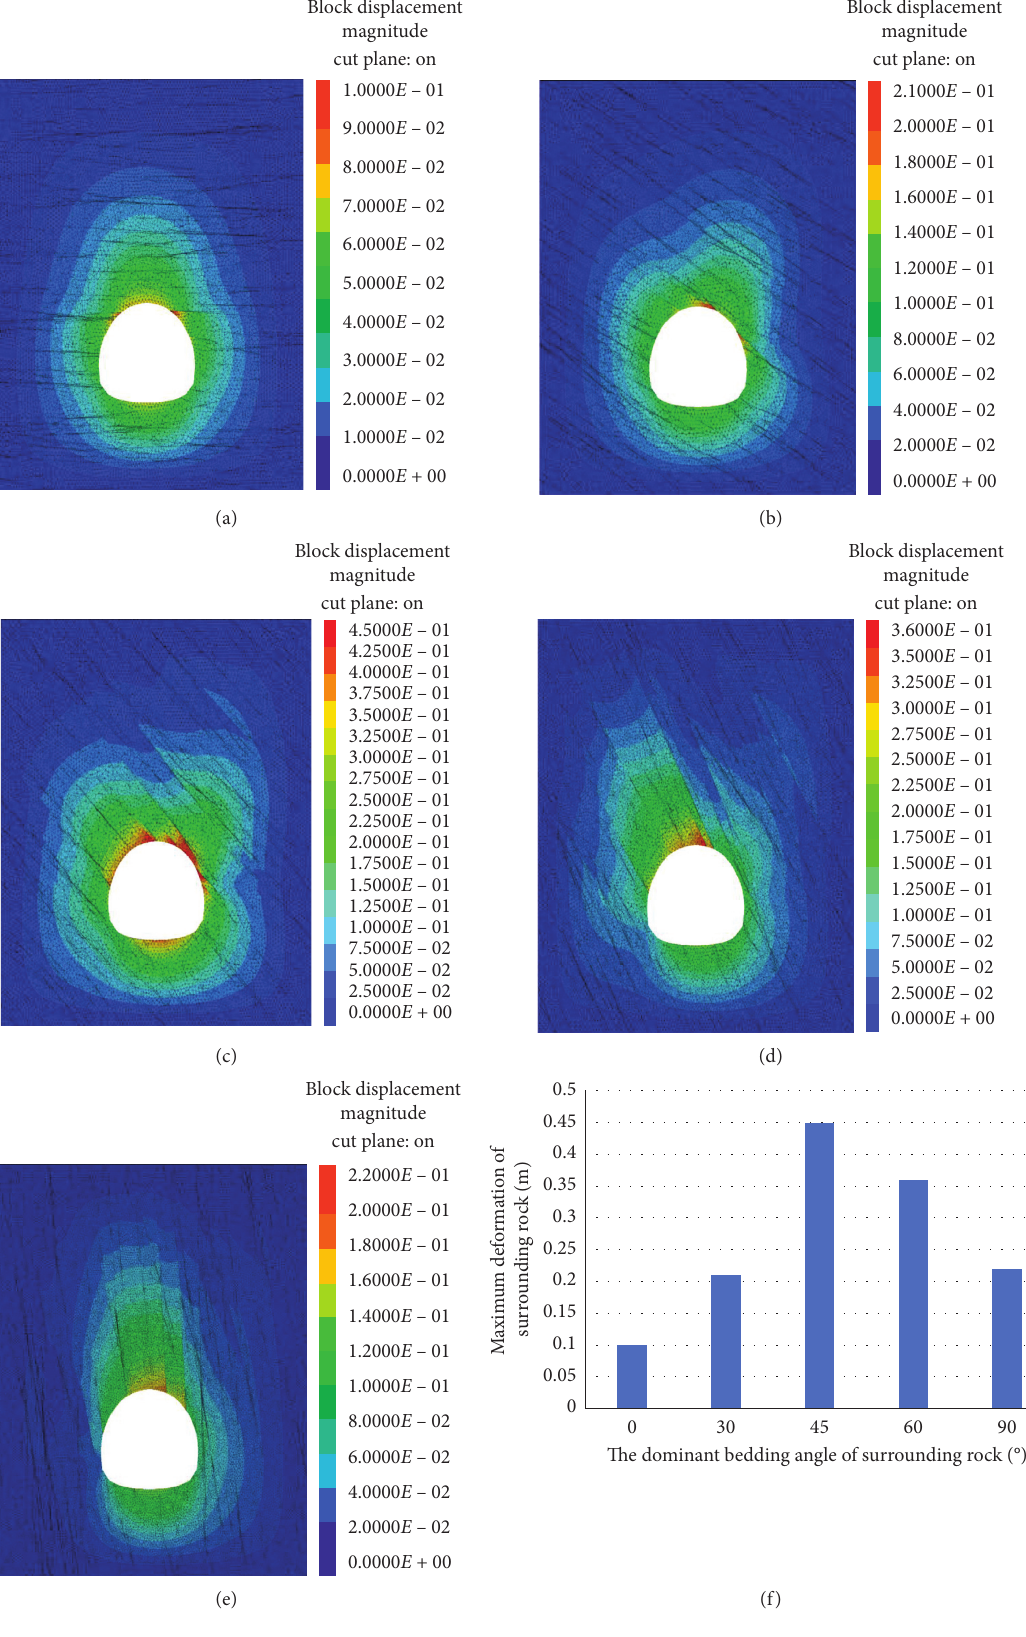
Figure 5: Different dip angles and deformation characteristics of surrounding rock. (a) The dominant joint angle 0 degrees. (b) The dominant joint angle 30 degrees. (c) The dominant joint angle 45 degrees. (d) The dominant joint angle 60 degrees. (e) The dominant joint angle 60 degrees. (f) Relationship between dip angle deformations of different surrounding